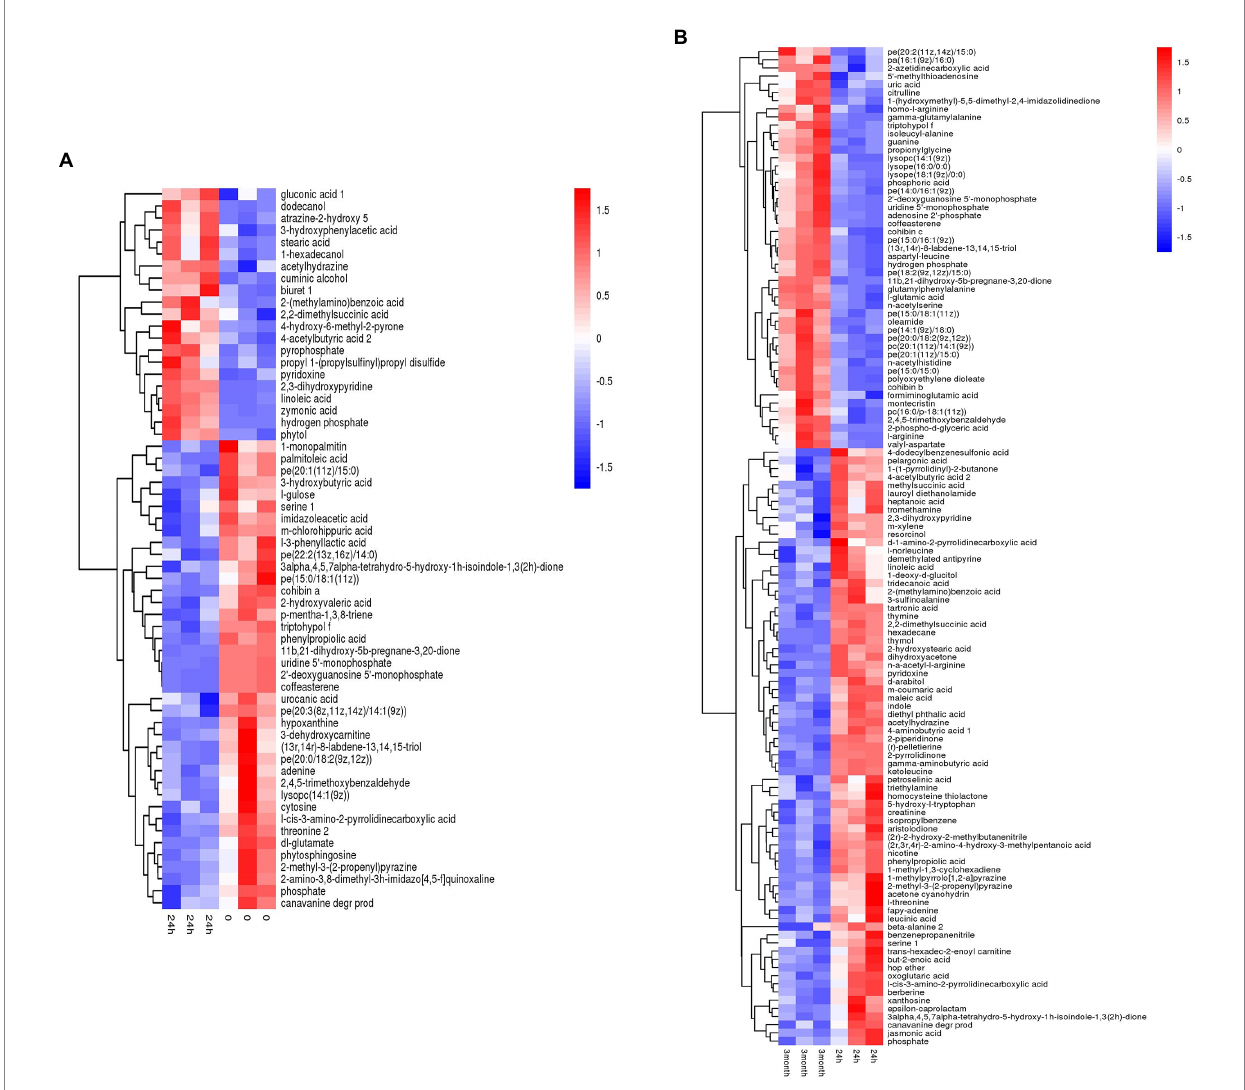
FIGURE 2 Heatmap of hierarchical clustering analysis of differentially expressed metabolites induced by (A) desiccation treatment and (B) SMP